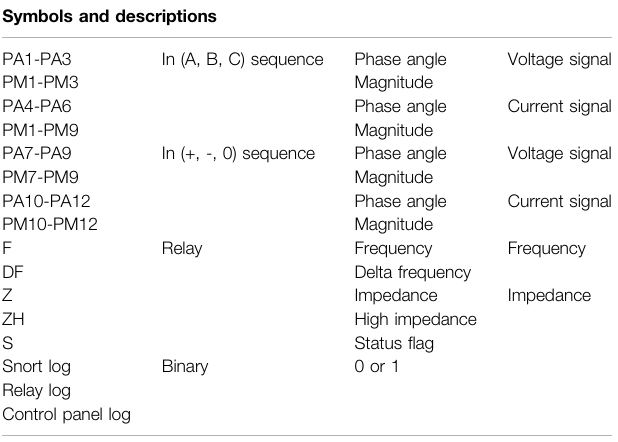
TABLE 6 | Symbols applied in the names of characteristics.